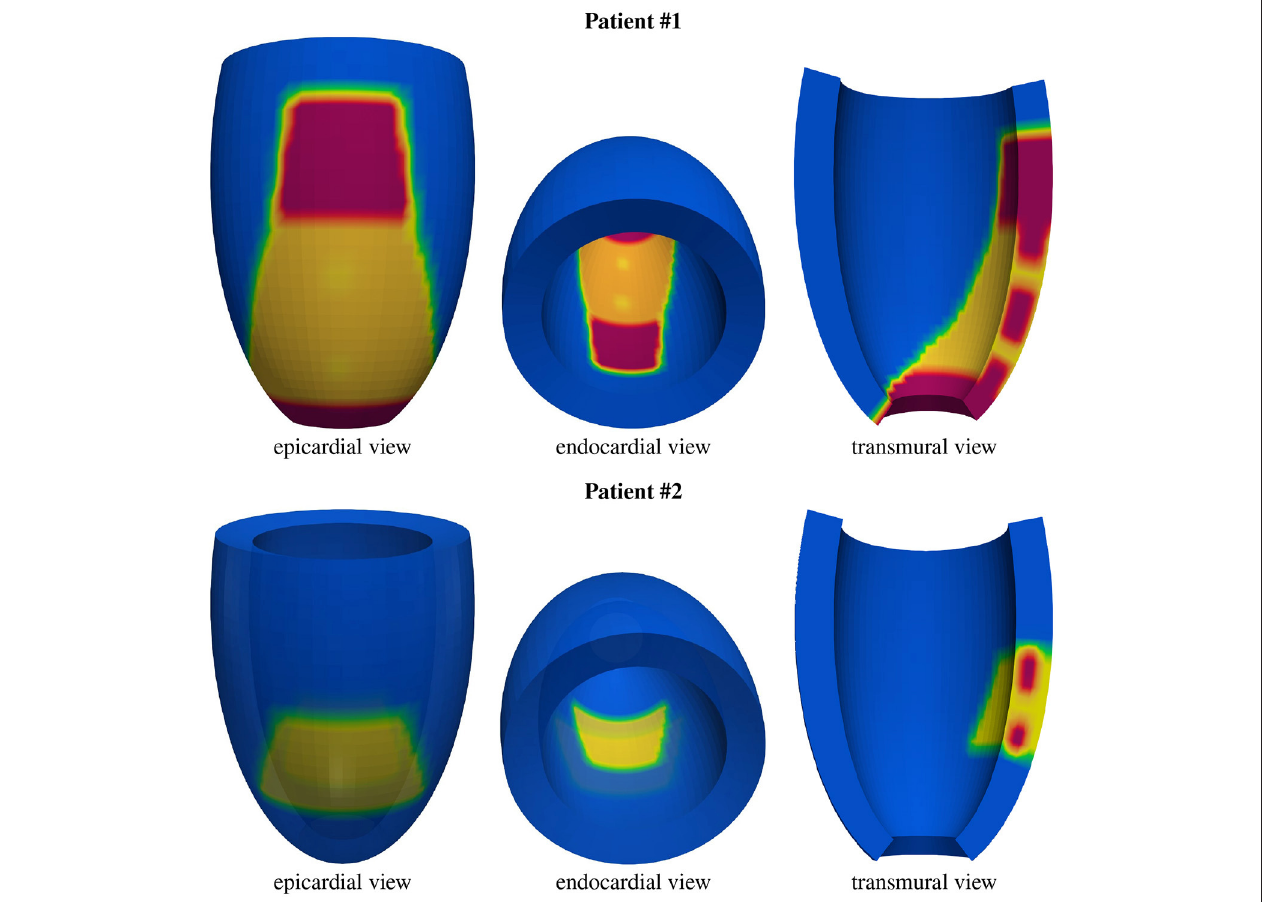
FIGURE 3 | Geometric models of the left ventricles of the two patients: healthy tissue (blue), border zone (BZ) tissue (yellow), scar tissue (red). From the transmural view, one can appreciate the transmural BZ isthmuses of the two patients.